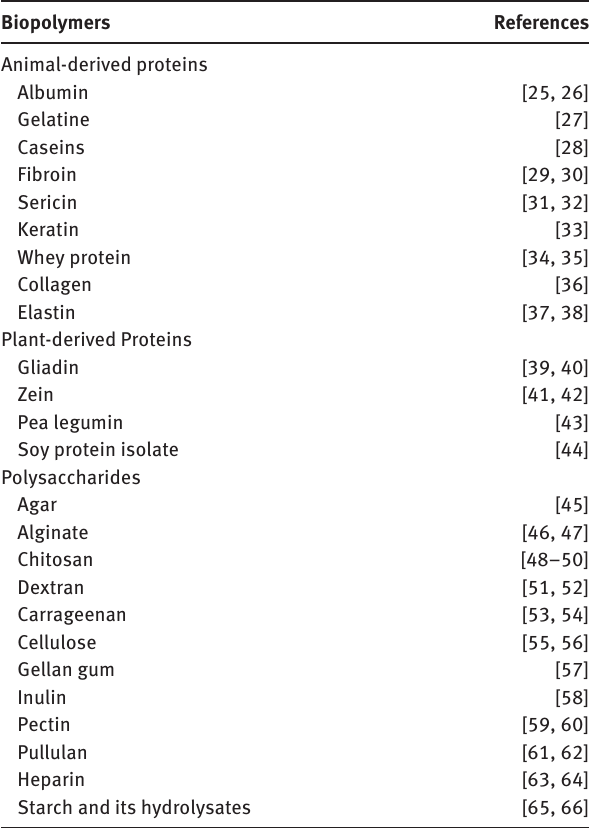
Table 1: Biopolymers for engineered nanoparticles – recent